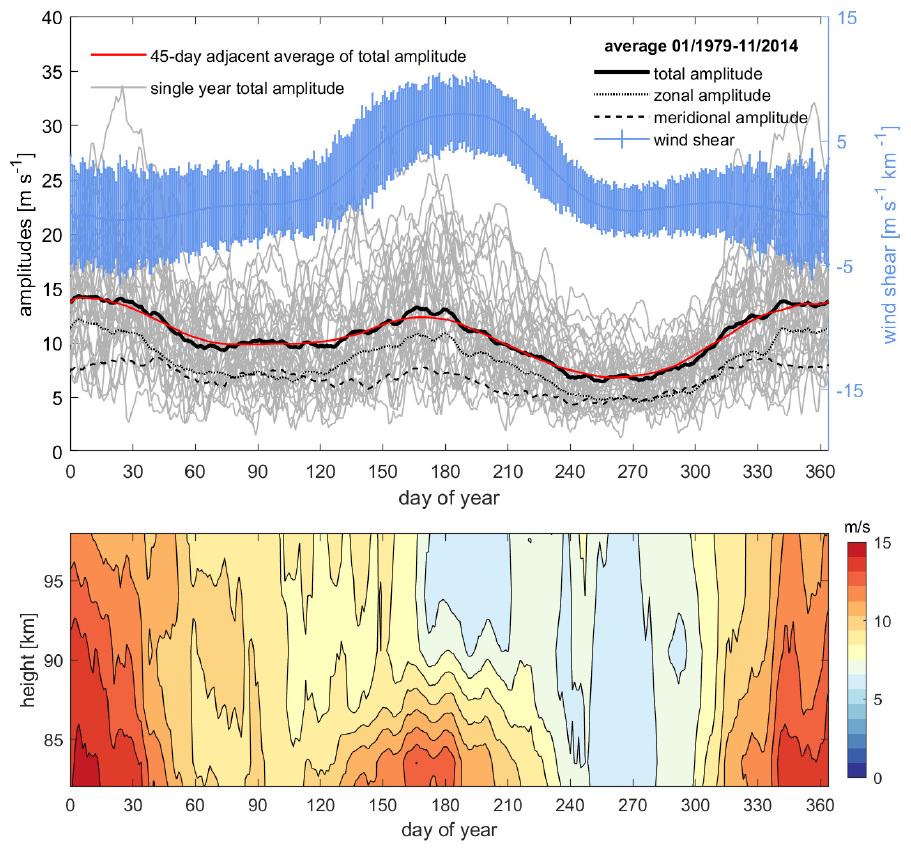
Figure 10. The same as Figure 9 but for the 35-year WACCM simulation. Baroclinic instability may not only vary annually but also affect Q16DW on a shorter timescale. Therefore, we next consider the possible relationship between the Q16DW amplitude and zonal wind shear during winter. To focus on the shorter timescales, we excluded the annual mean from both the amplitude of the wind shear and Q16DW. Then, two methods of superposed epoch analyses were applied to the anomalies of the wave amplitude and wind shear during the winter (November–March). For the first method, the central days are identified when the Q16DW are “active”. For the second method, the central days are identified when the wind shear is larger than 2 m s − 1 km − 1 . Once the central days have been identified, time windows from 70 days prior to the central days to 70 days after the central days are considered. The total Q16DW amplitude and wind shear anomalies within the windows are averaged over all cases for each of the methods. Figure 11 suggests that the anomalous Q16DW at 84 km has a positive correlation with the anomalous vertical wind shear; that is, the Q16DW tends to be enhanced as the baroclinic instability increases in the MLT region.